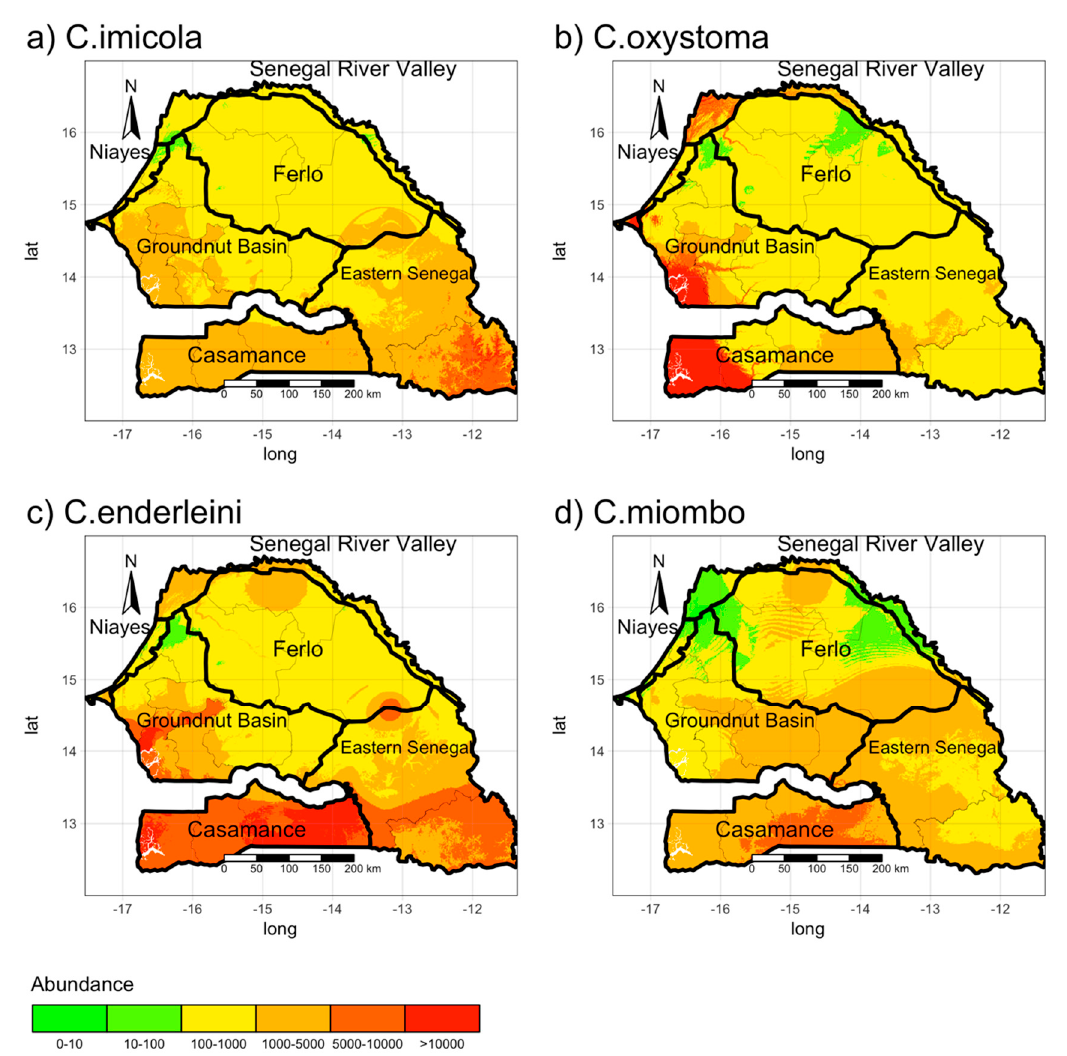
Figure 4. Maps of abundance of the four main Bluetongue virus (BTV) vector species in Senegal: ( a ) C. imicola ; ( b ) C. oxystoma ; ( c ) C. enderleini , and ( d ) C. miombo .